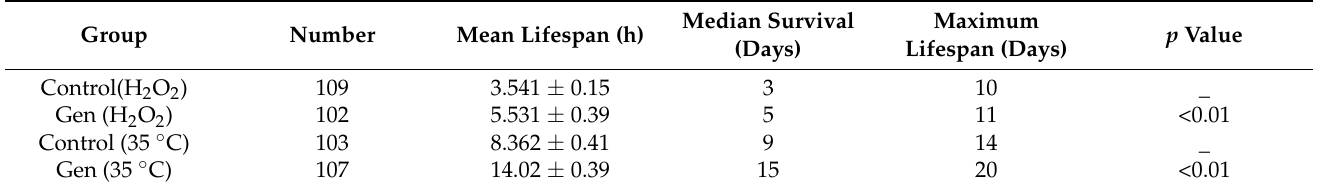
Figure 1. The effect of 200 µ M genistein on the survival rate of C. elegans under stress. ( A ) The change in survival rate of C. elegans exposed to H 2 O 2 -induced oxidation in the genistein and control groups. ( B ) The change in survival rate of C. elegans exposed to heat shock at 35 ◦ C in the genistein and control groups. Table 2. The effect of 200 µ M genistein on the lifespan of C. elegans under H 2 O 2 and 35 ◦ C